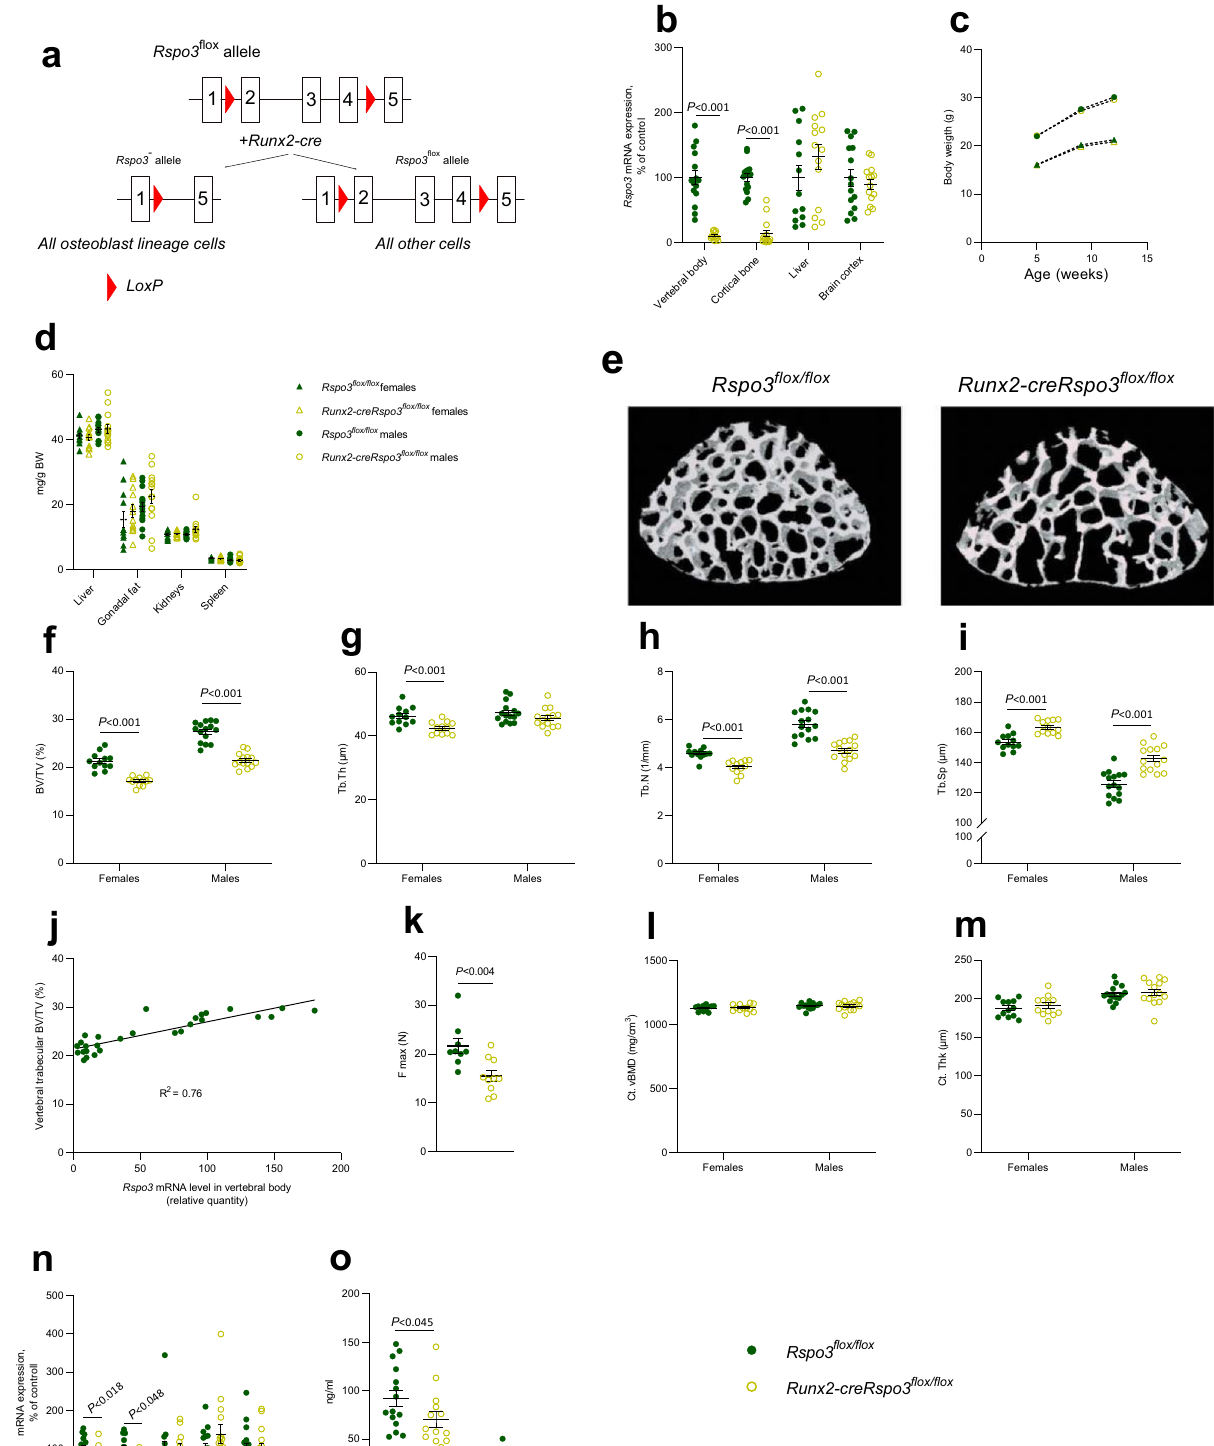
life-long inactivation of Rspo3 in osteoblast-lineage cells. No compensatory regulation of Rspo1, -2 or - 4 was observed (Fig. 3n). Circulating levels of the bone formation marker procollagen type I N-terminal propeptide (P1NP; Fig. 3o, left) were reduced while the levels of the bone resorption marker C-terminal type I collagen fragments (CTX; Fig. 3n, right) were unchanged in